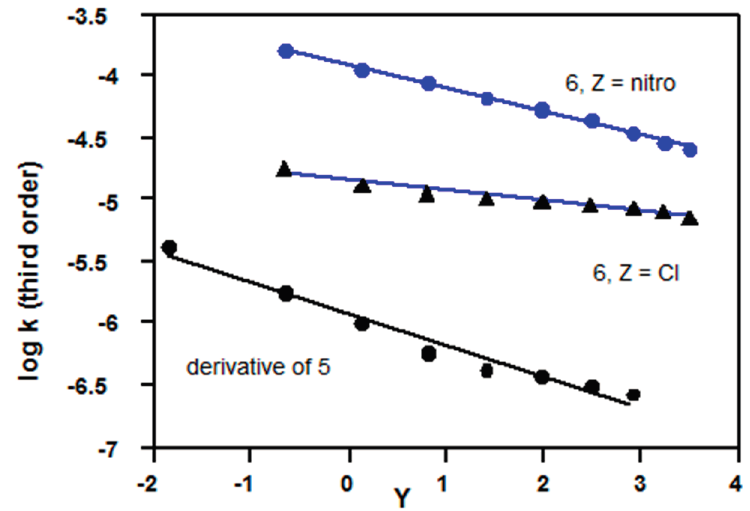
Figure 4. Plots of logarithms of third order rate constants (Equation (3)) vs. Grunwald-Winstein Y values [4,17] for acetone-water mixtures; kinetic data: for 5 , R = C(Me) 2 CCl 3 at 25 °C from Reference [26]; for p -chlorophenyl chloroformate ( 6 , Z = Cl) at 25 °C from Reference [14]; for p -nitrophenyl chloroformate ( 6 , Z = NO 2 ) at 25 °C from Reference